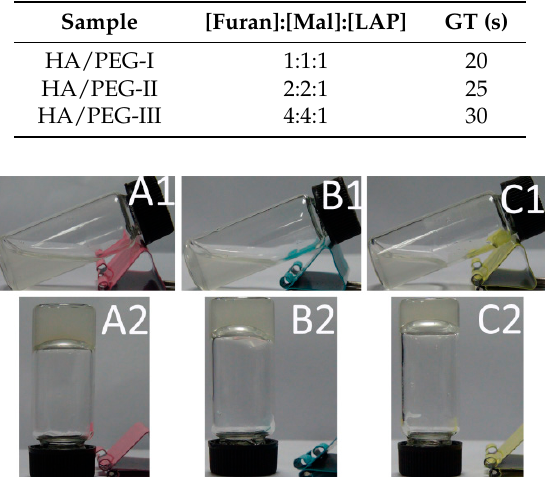
Figure 5. Gelation photos of HA/PEG hydrogels. ( A1 – C1 ) were the photos before gelation of HA/PEG-I, HA/PEG-II, HA/PEG-III, respectively; ( A2 – C2 ) were the photos after gelation of HA/PEG-I, HA/PEG-II, HA/PEG-III, respectively.